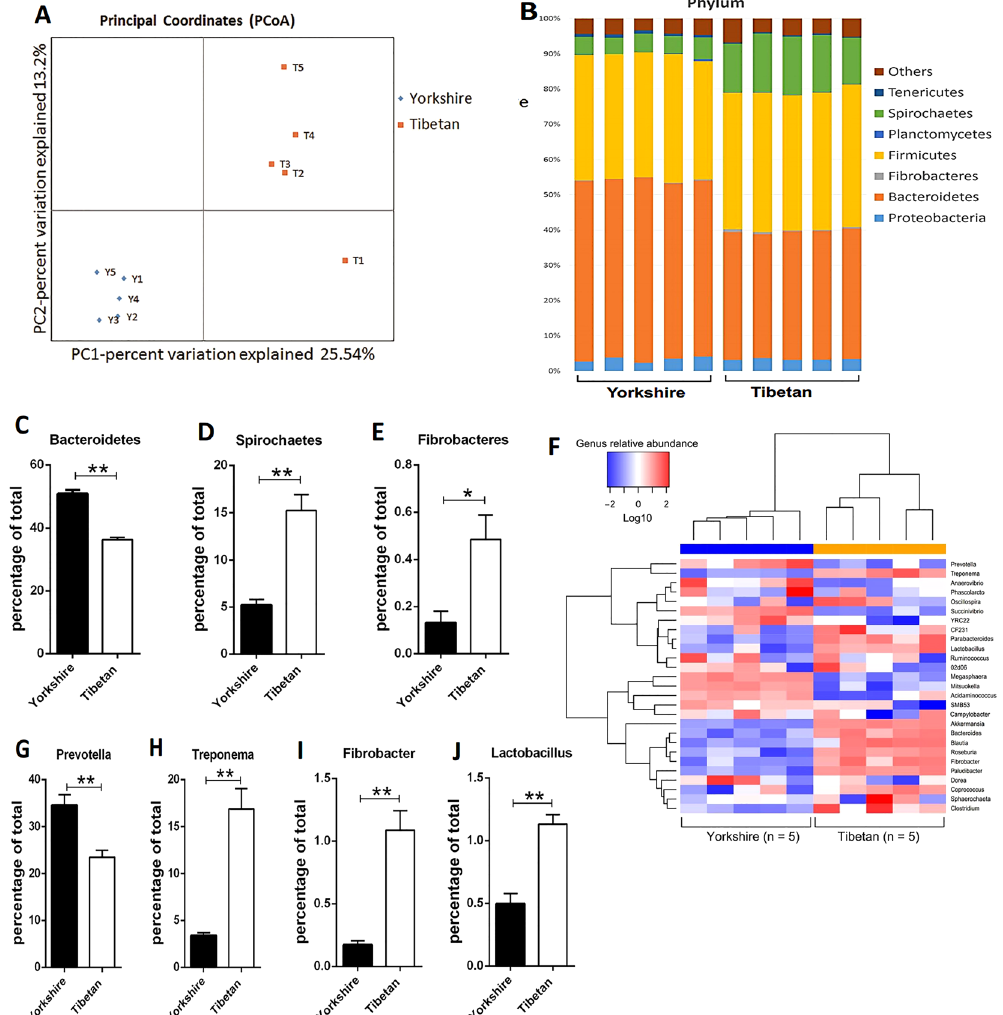
Figure 1. Analysis of the faecal microbiota of the Yorkshire and Tibetan pigs. ( A ) 16S rRNA gene surveys (analysed by unweighted UniFrac PCoA) of the faecal microbiota of the Yorkshire or Tibetan pigs (n = 10). PC1 and PC2 are shown on the x-axis and y-axis, respectively. The percentage of variance explained by each coordinate is shown in parentheses. ( B ) Relative abundance of the phyla in two pig strains (Yorkshire and Tibetan pigs). Groups within the same bacterial phylum are indicated by different shades of the same colour. Taxa with a mean relative abundance of > 1% are shown (n = 5 for each strain). ( C – E ) Percentage of Bacteroidetes, Spirochaetes and Fibrobacteres in the faeces of Yorkshire and Tibetan pigs (each n = 5) in the classification of phylum. ( F ) Heatmap of log10-transformed abundance levels of the selected genera ( > 0.1% in at least one sample) for the individual Yorkshire and Tibetan faecal samples (each n = 5). The pigs with the highest and lowest bacterial levels are in green and red, respectively. ( G – J ) Percentage of Prevotella , Treponema , Fibrobacter and Lactobacillus in the faeces of Yorkshire and Tibetan pigs (each n = 5) in the classification of